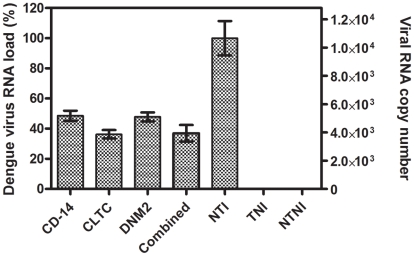
Extracellular dengue virus RNA load.DENV RNA in the culture supernatant of transfected and non-transfected monocytes was quantified by RT-qPCR. Result shows marked reduction in viral RNA (51.4%, 63.7%, 52.2%, and 63.0%) for CD-14 associated molecule, CLTC, DNM2, and combined silenced monocytes, respectively, when compared with non-transfected monocytes, which defined as 100% (viral RNA copy number is 1.06×104/µl). This result is statistically significant (One-way ANOVA with Dunnett's post-test, P<0.0001, Error bars are ± SD). (TNI, Transfected Non-Infected; NTI, Non-Transfected Infected; NTNI, Non-Transfected Non-Infected).